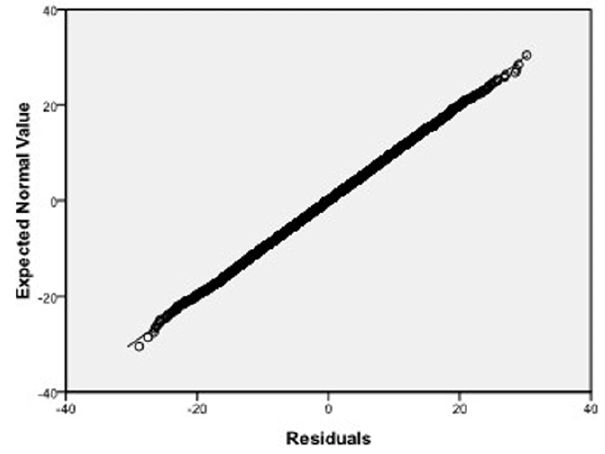
Figure 15. Normal Q-Q plot of residuals of ^ bb 2 of OLS when the variance function of the error term is s 2 ( x 1 , x 2 ) ~ exp ( { ( x 1 z x 2 )) .